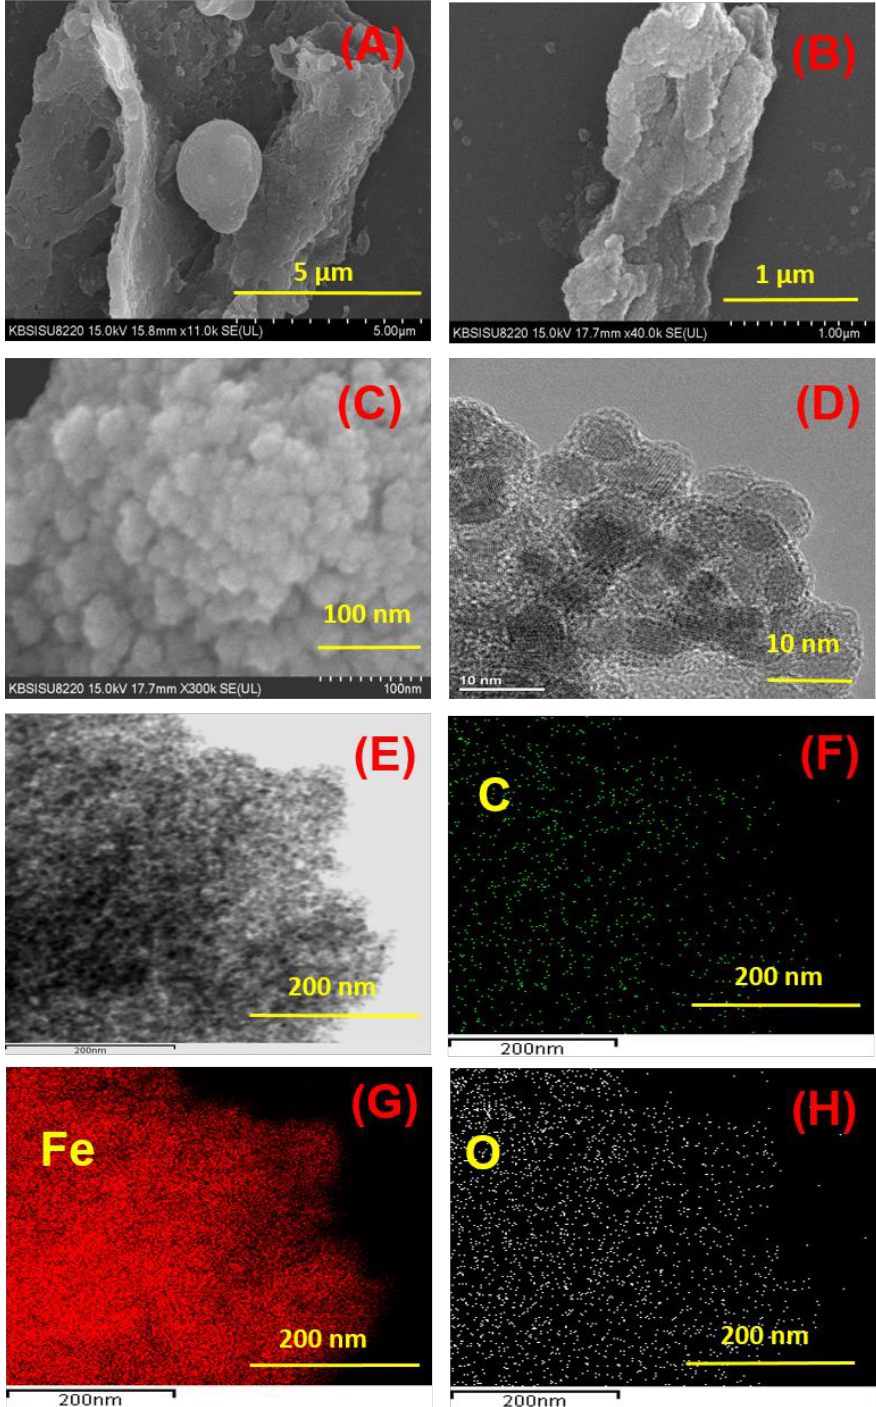
Figure 1. SEM image of ( A ) SCB hydrochar (SCB-H) and ( B ) SCB-H@Fe 3 O 4 , ( C ) the zoomed (100 nm) surface of SCB-H@Fe 3 O 4 , ( D ) HR-TEM image of the SCB-H@Fe 3 O 4 surface, ( E ) HAADF-STEM image of SCB-H@Fe 3 O 4 , and EDS elemental mapping images of ( F ) carbon (C), ( G ) iron (Fe) and ( H ) oxygen (O).